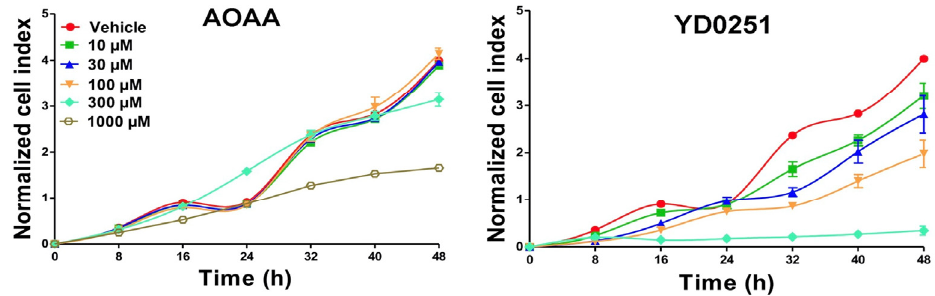
Figure 4. Effects of different concentrations of AOAA (left panel) and YD0251 (right panel) on HCT116 cell proliferation In Vitro. HCT116 cells were treated either with vehicle (i.e., test compound diluent) or different concentrations of the test compounds (10–1000 μ M), and proliferation was monitored for 48 h. Proliferation rates were monitored using the xCELLigence Real-time Cell Analyzer as described [17]. Data are shown as mean of n = 6 technical replicates at each time point.